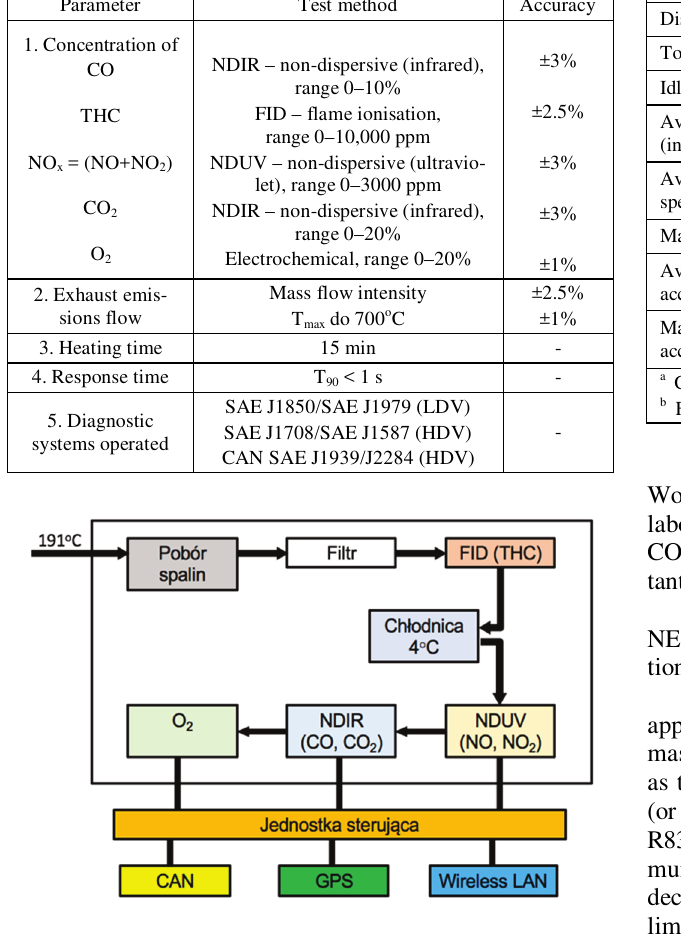
Table 1. Characteristics of SEMTECH DS mobile exhaust emissions analyser [11] Parameter